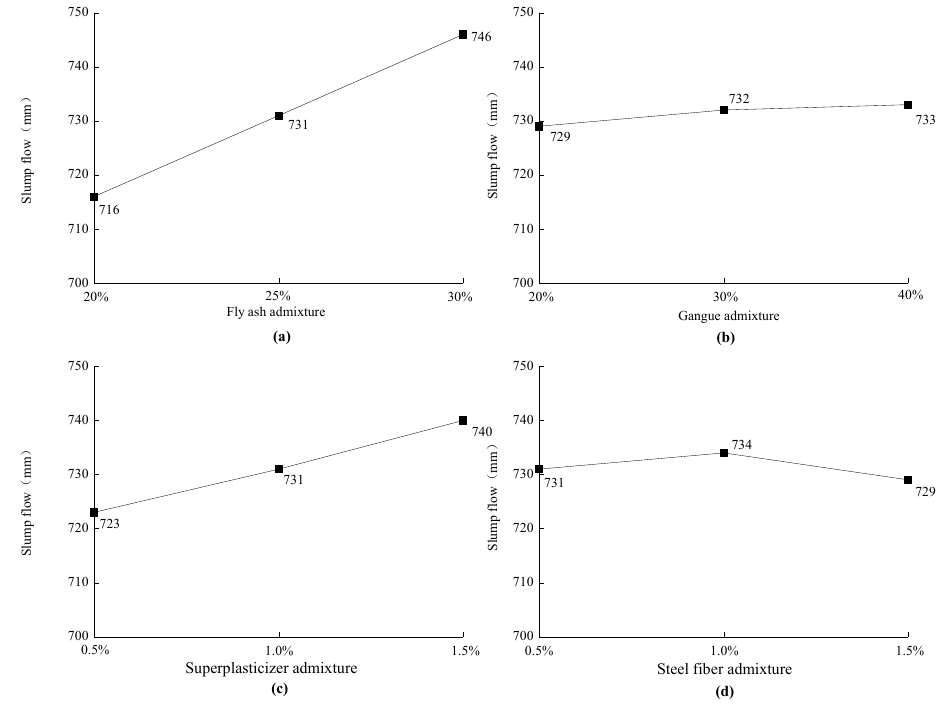
Figure 9. Influence of various factors on slump flow of concrete. ( a ) The influence of fly ash on the slump flow of concrete. ( b ) The influence of gangue on the slump flow of concrete. ( c ) The influence of superplasticizer on the slump flow of concrete. ( d ) The influence of steel fiber on the slump flow of concrete.